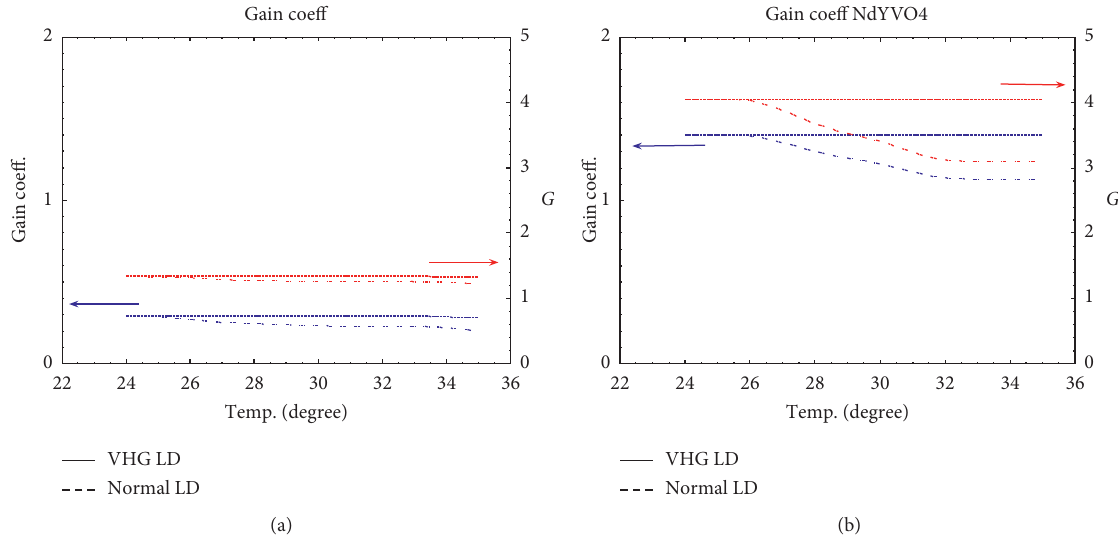
Figure 7: Calculated small signal gain coefficient and laser large gain: (a) Nd:YAG and (b) Nd:YVO